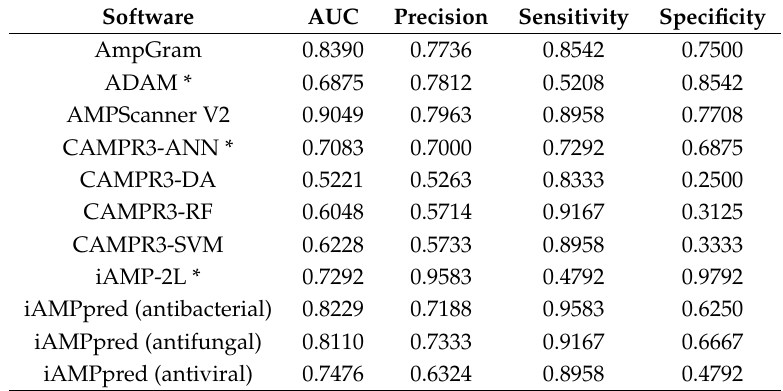
Table 3. Comparison of AmpGram performance with other top-ranking predictors for 61–710-amino-acid-long AMPs. Programs that do not provide prediction probability are marked with